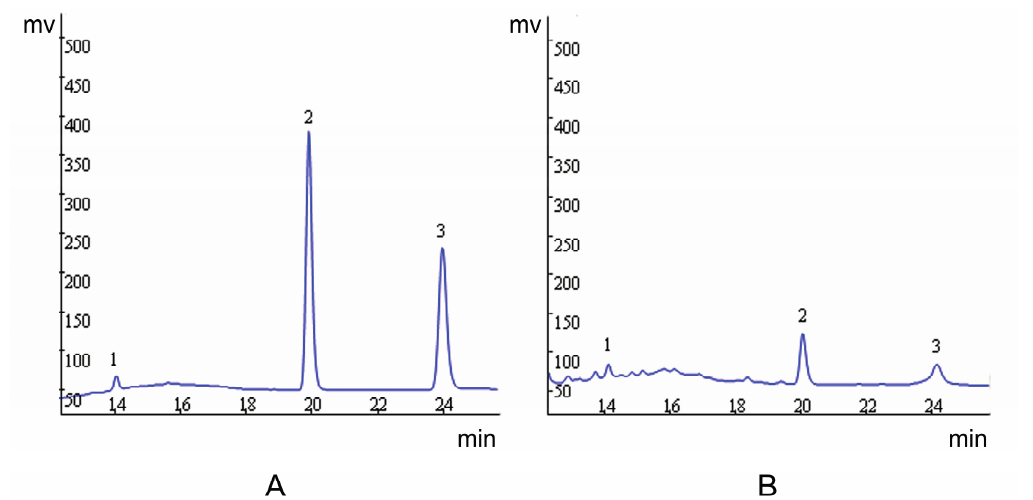
Figure 1. Representative high performance liquid chromatography profile of standard ( A ) and aqueous extract of EF ( B ). Evodine (1), evodiamine (2) and rutaecarpine